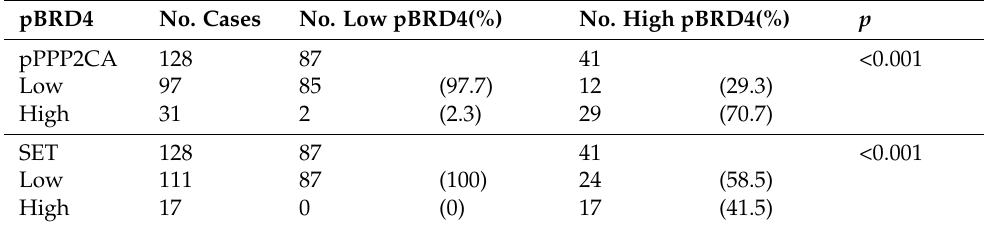
Table 3. Association between pBRD4 expression and PP2A activation status in TNBC